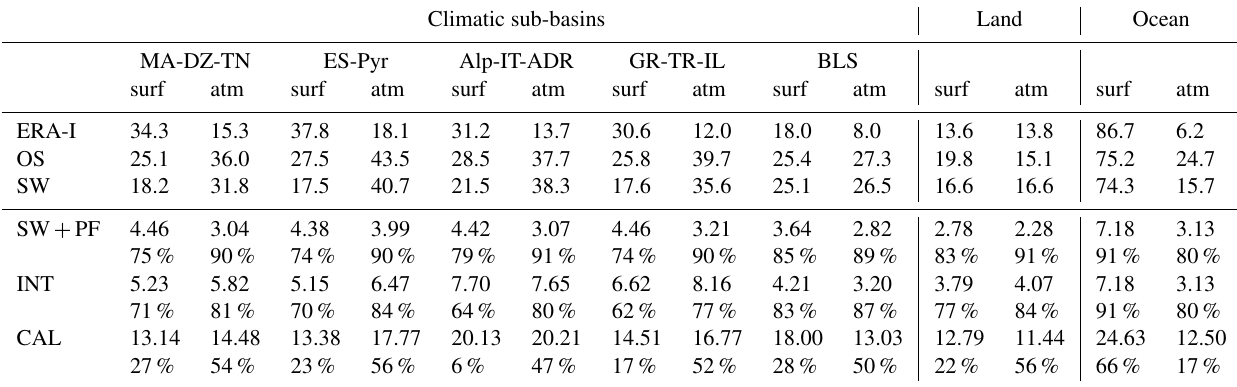
Table 4. rms of the WC budget residual (in mmmonth − 1 ) over the sub-basin using OS, SW, SW + PF, INT and CAL solutions and for the period 2004–2009. Percentage of improvement of the rms of the residuals from the SW solution to constrained methods is also shown. For comparison purposes, the result using the ERA-I dataset is also